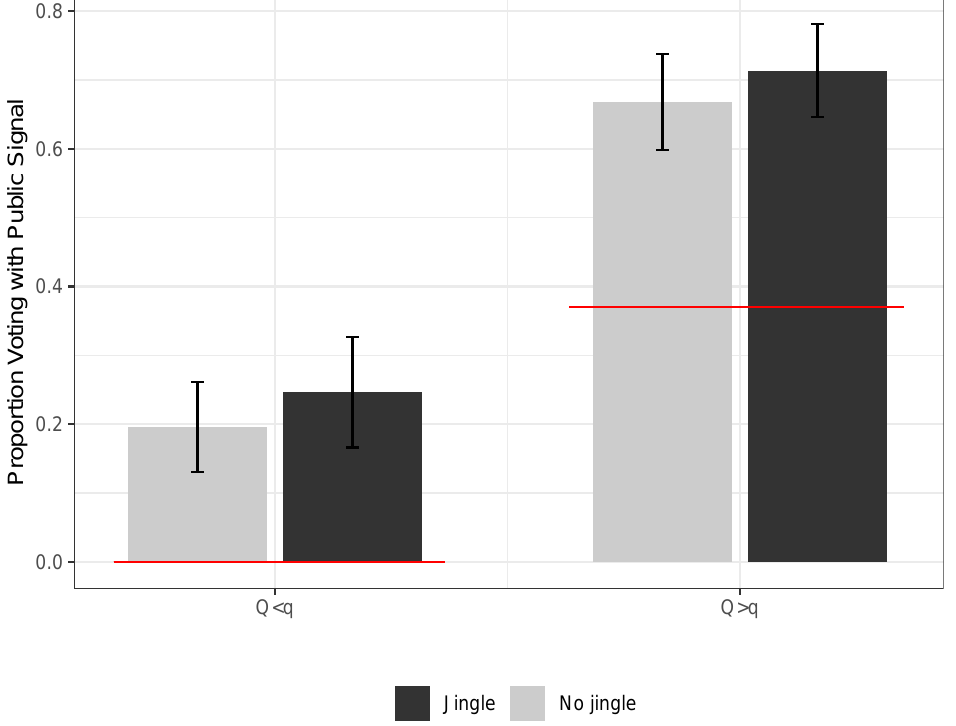
Figure 5. Jingle effect : Average fraction of votes with public signal under mismatch, and 95% confidence intervals. Standard errors are clustered at the individual level. Dark columns correspond to rounds where the public signal is displayed with the jingle. Horizontal lines represent symmetric responsive equilibrium predictions for µ